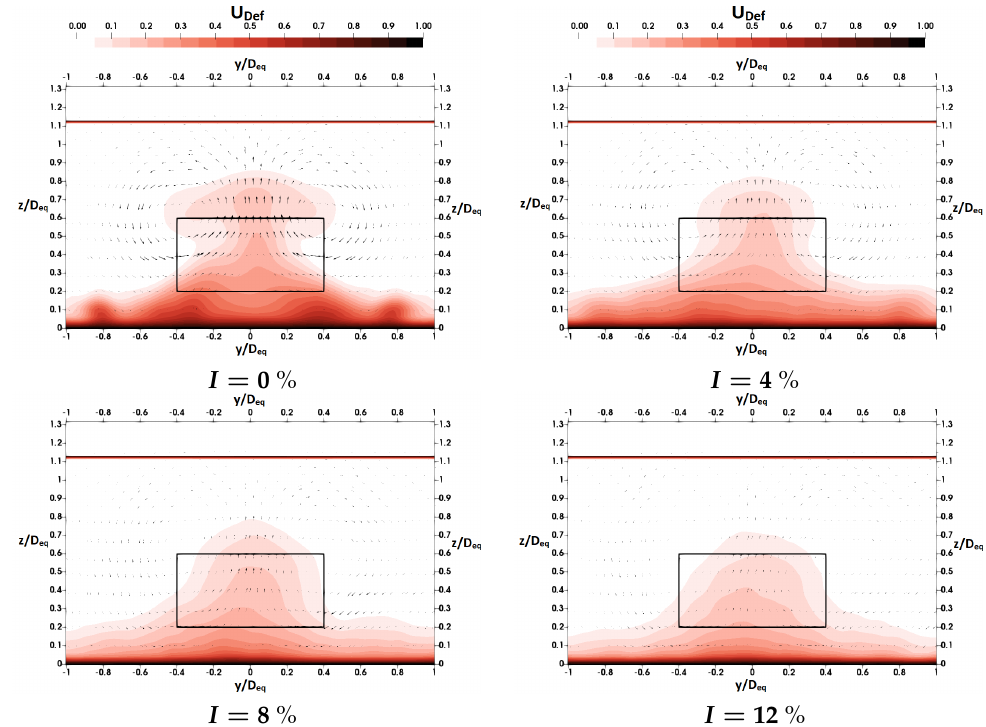
Figure 22. Contour of axial velocity deficit, 5.2 D eq downstream of the turbine. Velocity vectors are projected onto the plane. Turbine footprint is delimited in black. ALM-LBM simulations with four turbulence rates. U Def = 1 − < U x > / U ref